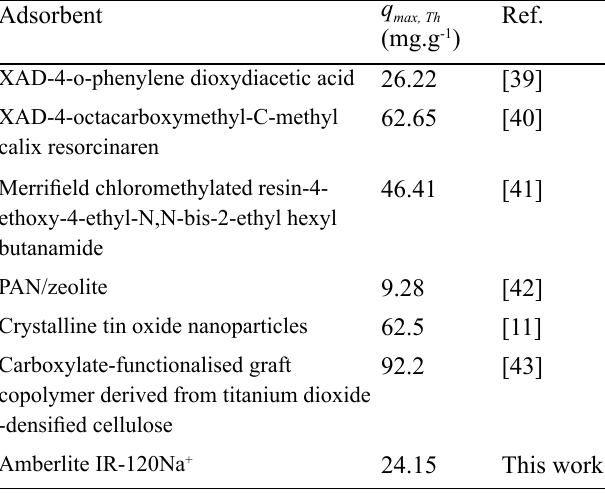
Table 8. Comparison of the various sorbents used for Th(IV)